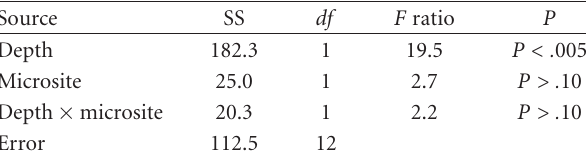
Table 2: ANOVA of the e ff ects of soil depth and microsite on maximum temperatures recorded during a controlled burn in sand pine scrub at Ocala National Forest, Florida. Temperatures were recorded with copper-constantan thermocouples placed at the soil surface and at 2cm depth, and in open and vegetated microsites. Data were rank-transformed prior to the ANOVA.